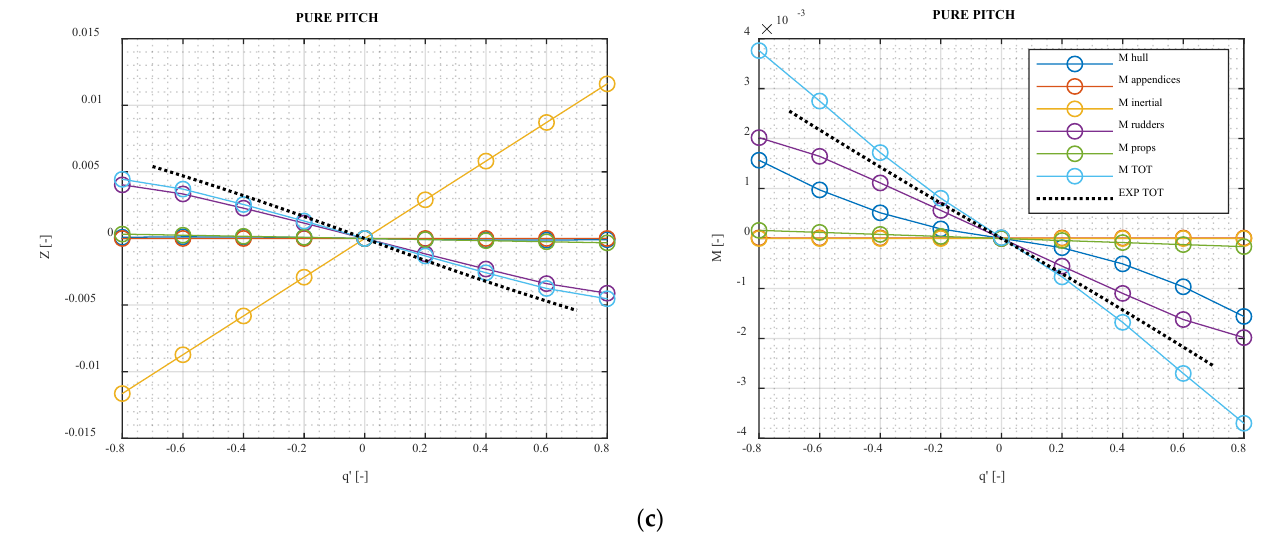
Figure 9. ( a ) SMG captive model testing validation—horizontal plane. ( b ) SMG captive model testing validation—horizontal plane roll. ( c ) SMG captive model testing validation—vertical plane.